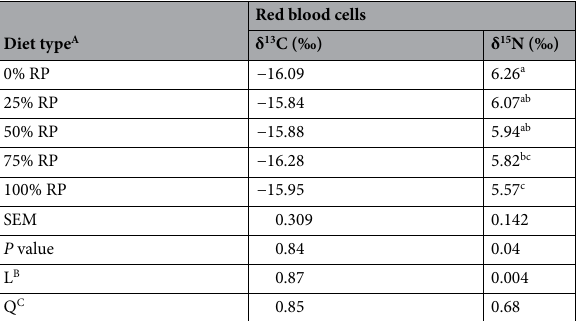
Table 2. δ 13 C and δ 15 N composition of red blood cells from beef steers consuming increasing proportions of rhizoma peanut (RP) hay in bahiagrass hay. Values are averages across five evaluations. A Indicates percent (%) inclusion of rhizoma peanut (RP) hay into bahiagrass. B L, indicates P value of linear polynomial contrast. C Q, indicates P value of quadratic polynomial contrast. a–e Means within a column followed by a common letter are not significantly different, according to LSD at the 5% significance level.